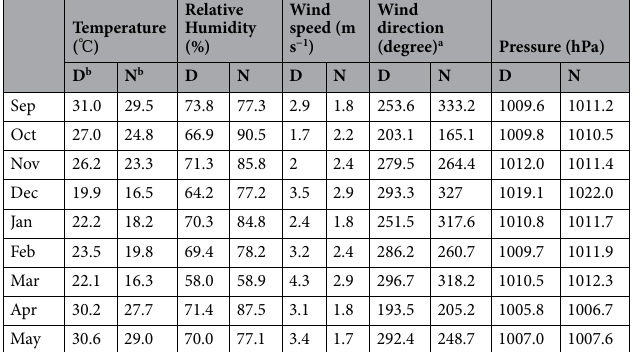
Table 1. Meteorological information of the study site during the sampling periods. a The angle measures clockwise rotation. b D and N denote daytime and nighttime,